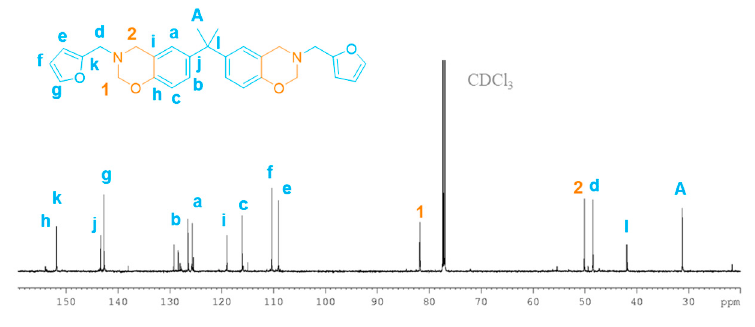
Figure A33. 1 H NMR spectrum in CDCl 3 of BA-fa.